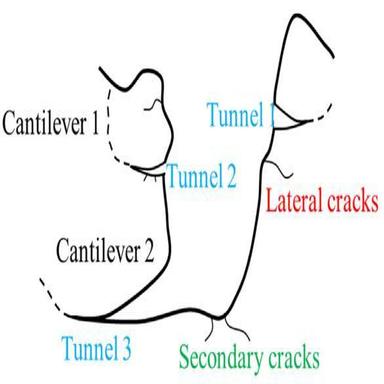
Schematic of damage mechanism at the advance stage of rain erosion.